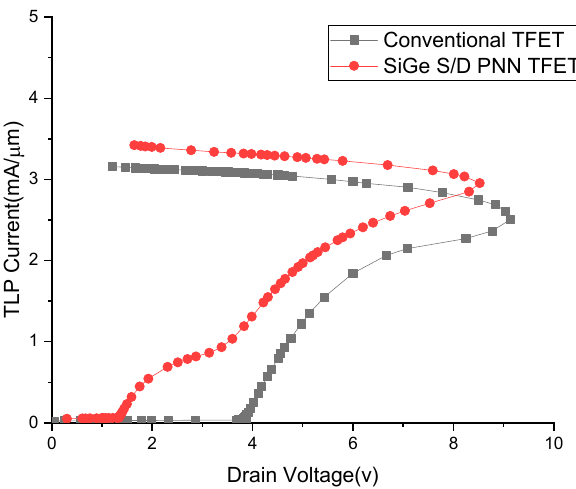
Figure 3. TLP I–V diagram of PNN TFET and Conventional TFET.